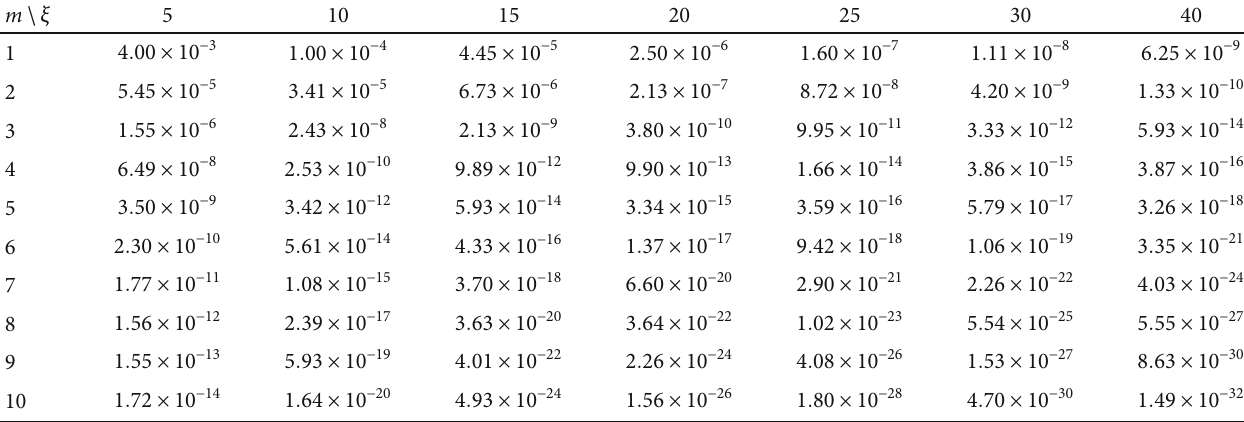
Table 3: Solution error of F ð 0, ξ Þ with increase in order of LSPM approximation when Pr = 10 , n = 0 : 5 , K = 0 : 5 , Ω = 0 : 1 , S = 3 , N He = 0 : 2 .